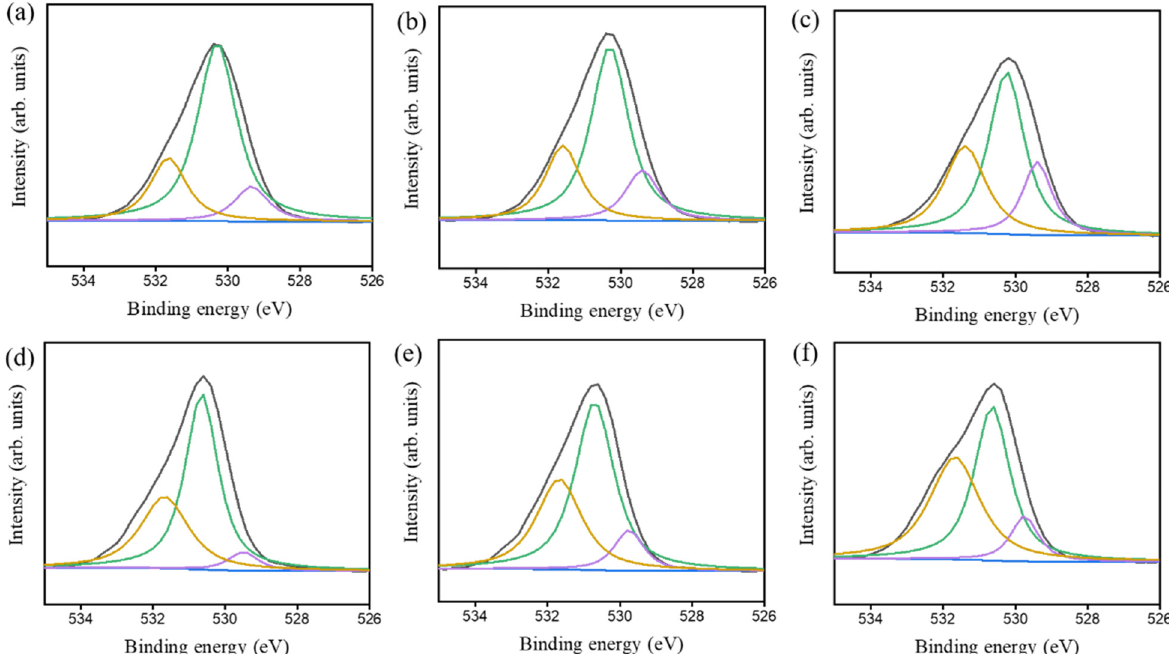
Figure 8: High - resolution O 1s XPS spectra and their deconvolution results of various thin fi lm samples: ( a ) SA130, ( b ) SA200, ( c ) SA270, ( d ) CSA130, ( e ) CSA200, and ( f )